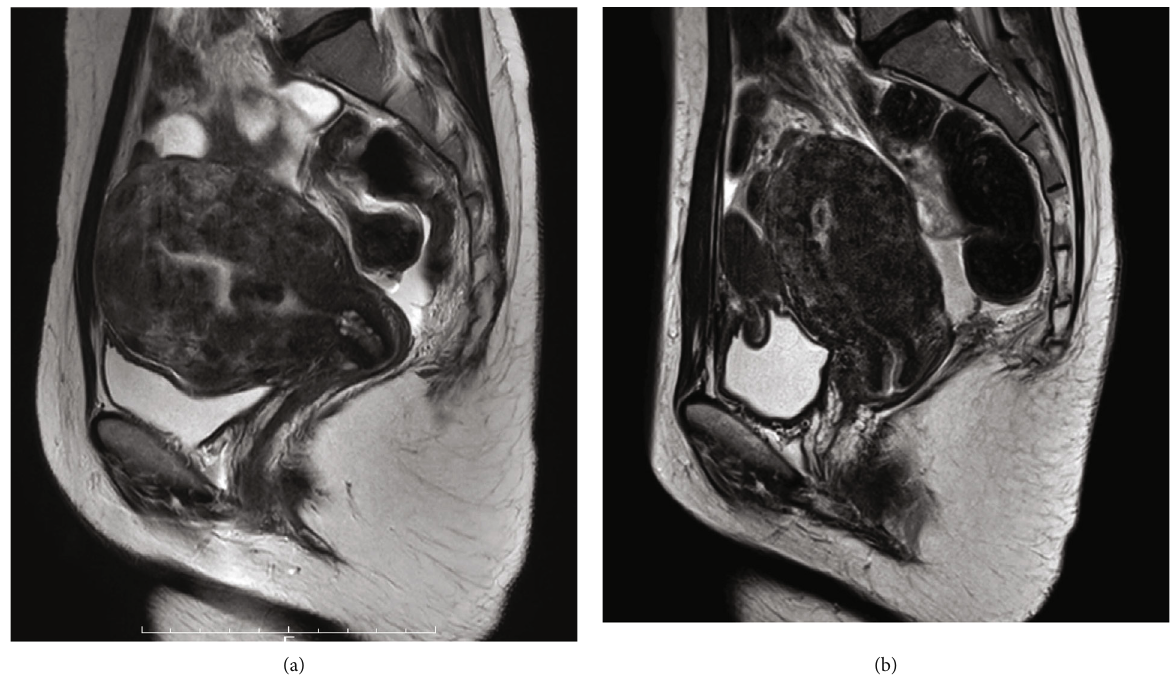
Figure 1: MRI T2-weighted fi ndings of di ff use uterine leiomyomatosis (a) before and (b) after extensive myomectomy.